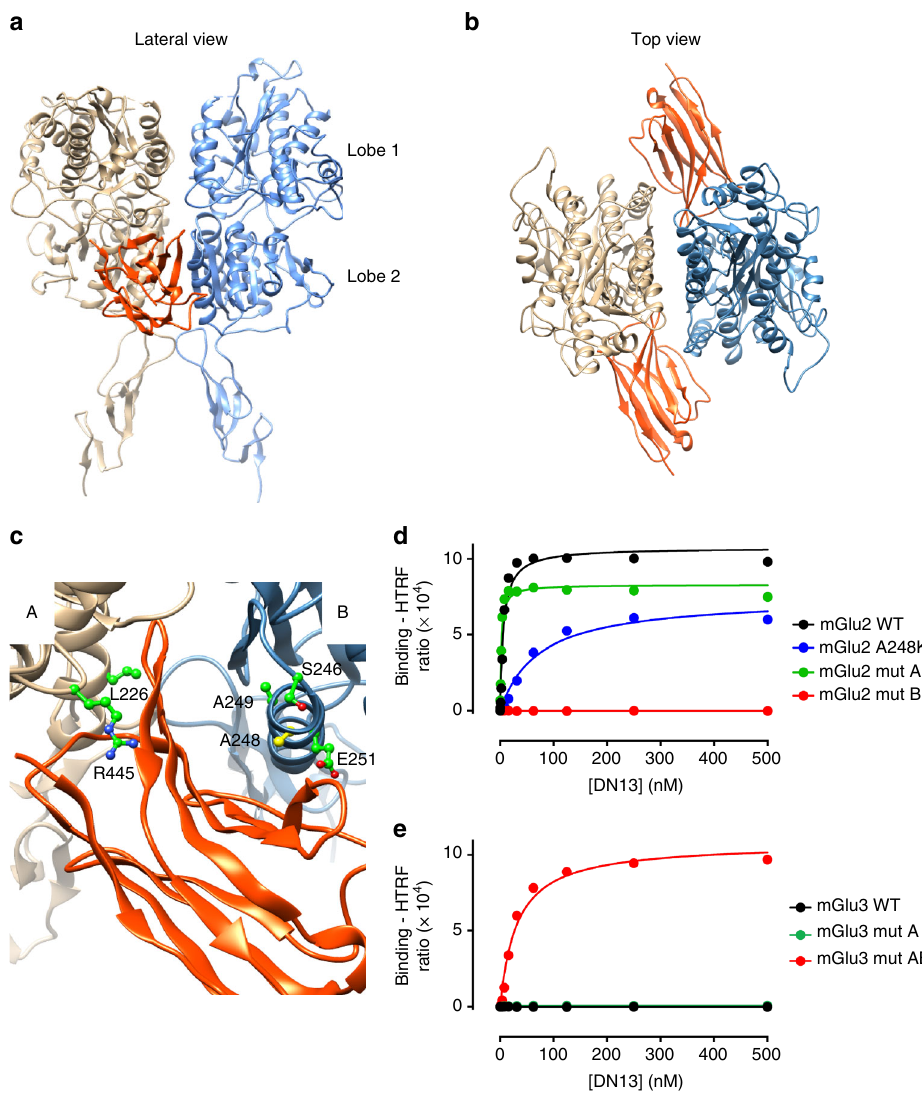
Fig. 3 DN13 interacts at the lobe 2 crevice on the activated mGlu2 VFT dimer. a , b View of the proposed docking of DN13 (orange) on the mGlu2 extracellular domain dimer ( a , lateral view, b , top view). c Detailed view of the proposed docking of DN13 illustrating proposed residues involved in selectivity, shown are Leu226 and Arg445 in protomer A, and Ser246, Ala248 (yellow), Ala249, and Glu251 in protomer B. d Saturation binding curves of DN13 on mGlu2 WT, mGlu2 bearing mGlu3 speci fi c residues from protomer A (mut A), mGlu2 bearing mGlu3 residues from protomer B (mut B), mGlu2 A248K mutant. e Saturation binding curves of DN13 on mGlu3 WT, mGlu3 bearing the mGlu2 residues on protomer A (mut A), and mGlu3 bearing all identi fi ed residues of mGlu2 (mut AB) in cells co-transfected with EAAC1. Data are mean ± SD of triplicates from a typical experiment representative of three